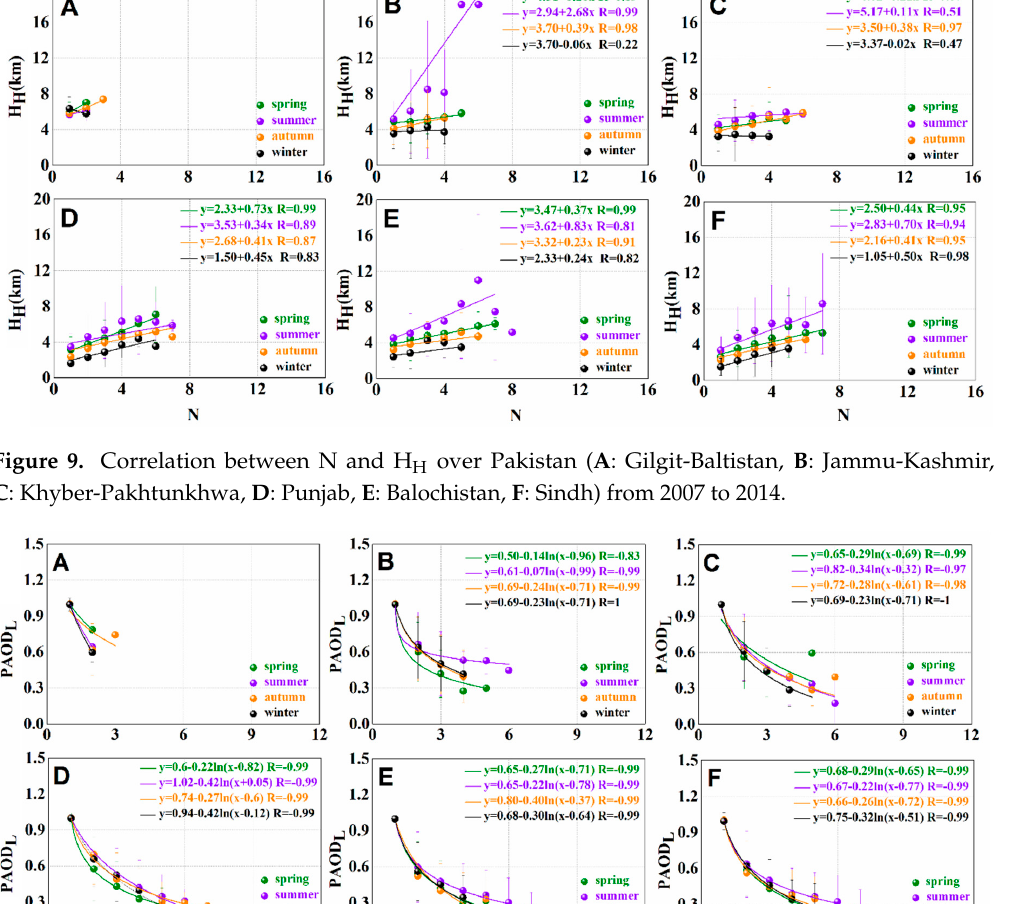
Figure 8. Correlation between AOD L and T L over Pakistan ( A : Gilgit-Baltistan, B : Jammu-Kashmir, C : Khyber-Pakhtunkhwa, D : Punjab, E : Balochistan, F : Sindh) from 2007 to 2014. Figure 9 depicts the correlation between N and H H over Pakistan. Because of less stratification over the three regions A, B, and C, especially over A, where the maximum value of N does not exceed 3, resulting in an inconspicuous positive linear correlation between N and H H . The maximum value of N over D, E, and F is ~7, which has a strong positive correlation with H H . These phenomena reveal that the higher the H H , the larger the N values in most cases. These results are consistent with the existing knowledge and the reported results for the Yellow River Basin and the Qinghai Tibet Plateau. [45,58].